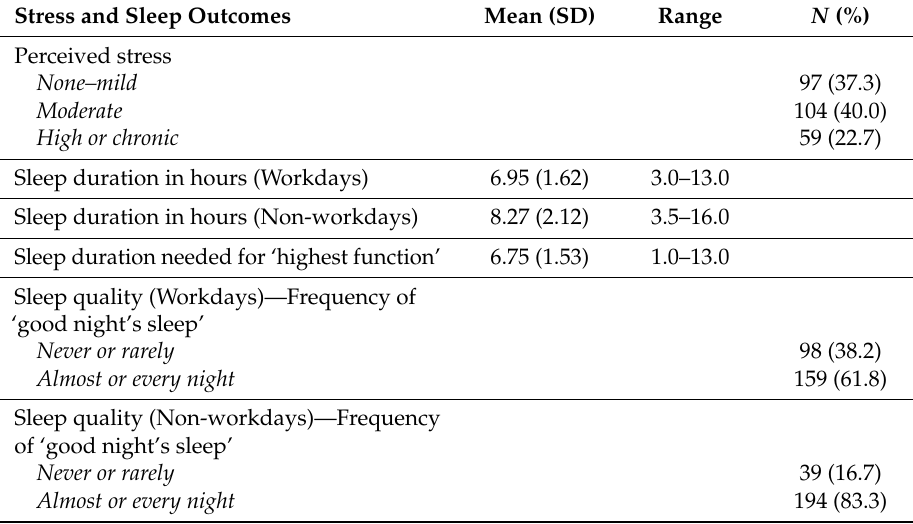
Table 2. Perceived stress and sleep outcomes.